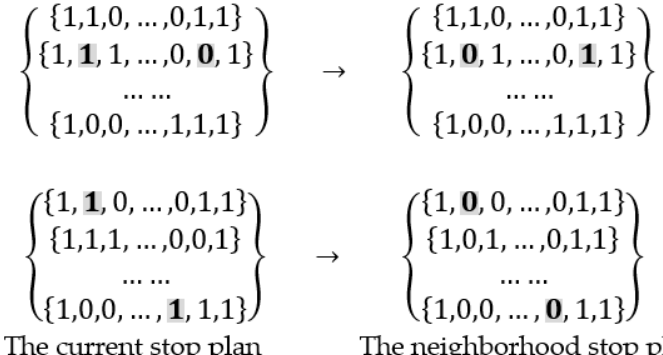
Figure 3. Neighborhood structure of train stop plan.